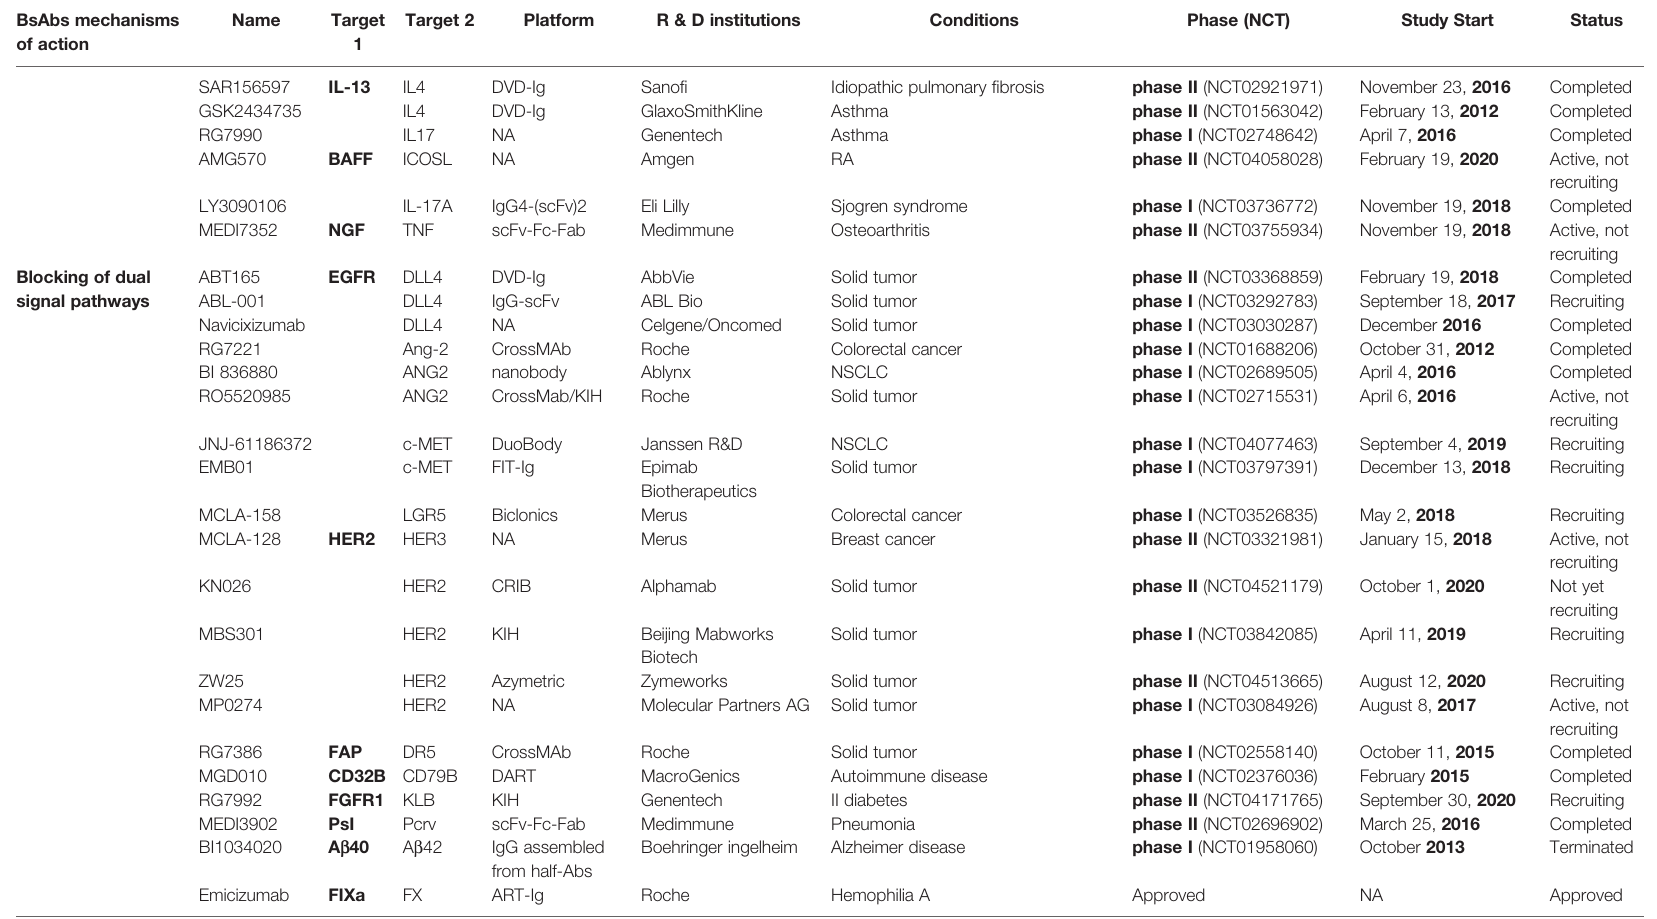
Data come from clinical trials, IMGT and referenced 128 and